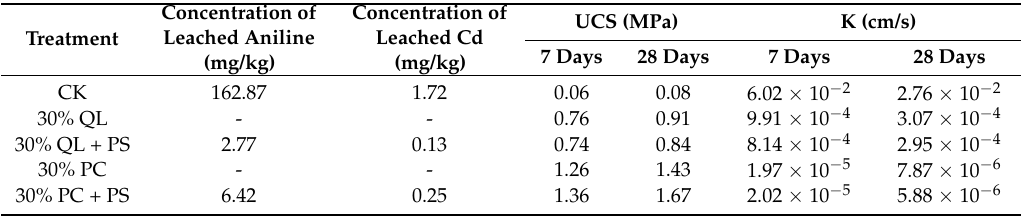
Table 5. Leaching of toxic contaminants and the unconfined compressive strength (UCS) and hydraulic conductivity (K) of treated soil samples cured for 7 or 28